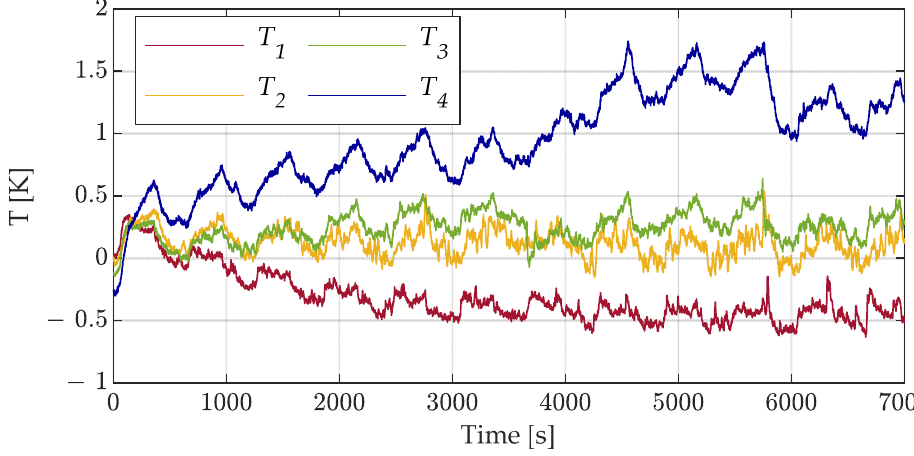
Figure 20. Error test three cells 45 A.